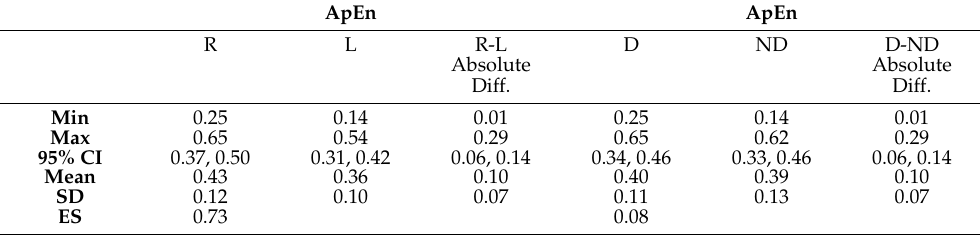
Table 2. Summary statistics and effect sizes for approximate entropy (n =